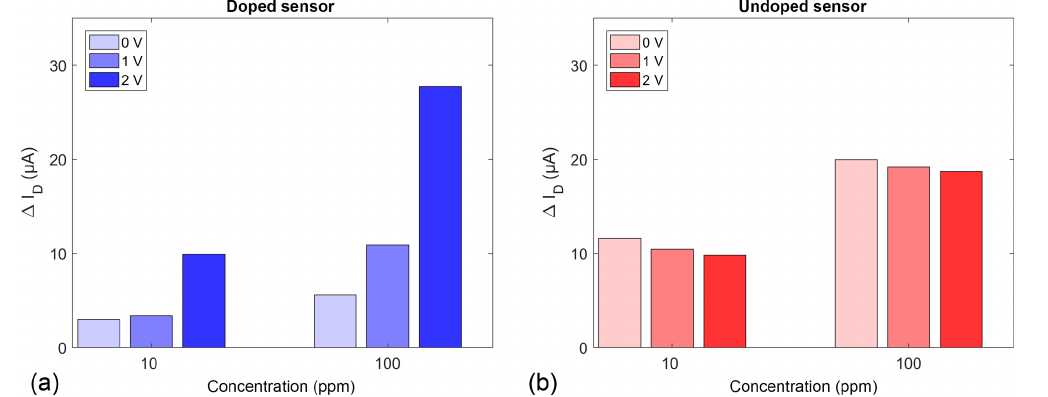
Figure 4. Sensor response at different gate biases of 0, 1, and 2V for a doped (a) and an undoped (b) sensor at 10 and 100ppm NH 3